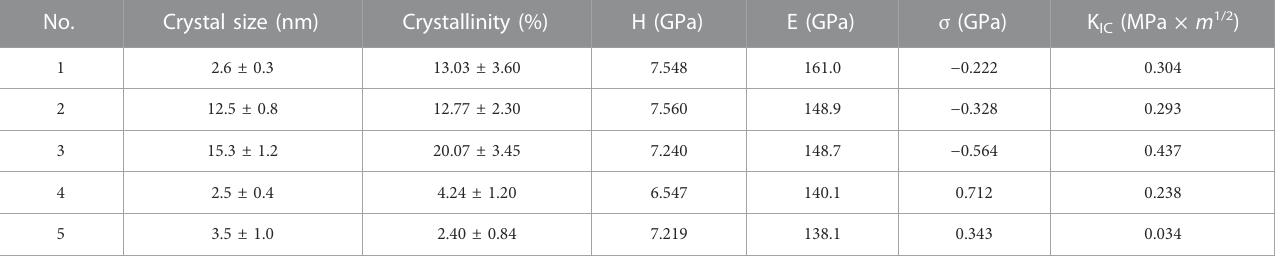
TABLE 2 The crystallite size, crystallinity, hardness (H), elastic modulus (E), residual stress ( σ ), and fracture toughness (K IC ) of the ZrNbTiMo RHEA fi lms. No. Crystal size